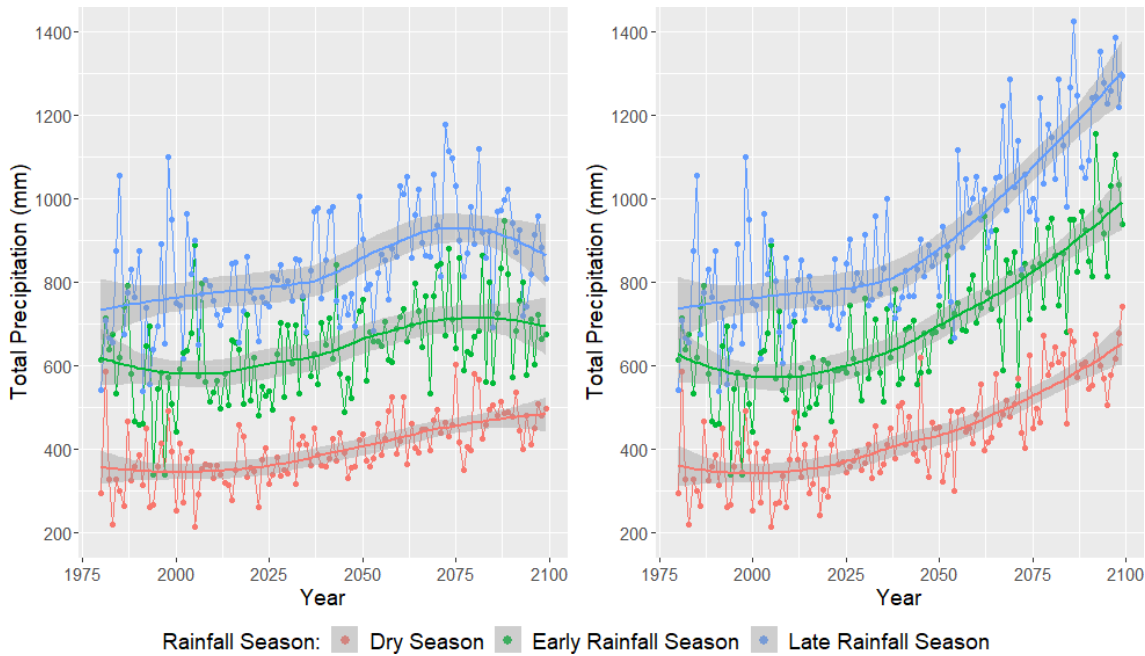
Figure C3. Average total precipitation (mm) per weather station by rainfall season for the UK’s HadGEM2 RCP4.5 forcing scenario (left) and the RCP8.5 forcing scenario (right). Historical GHCN observations are also indicated on these plots (1980–2005). This figure was created using Wickham